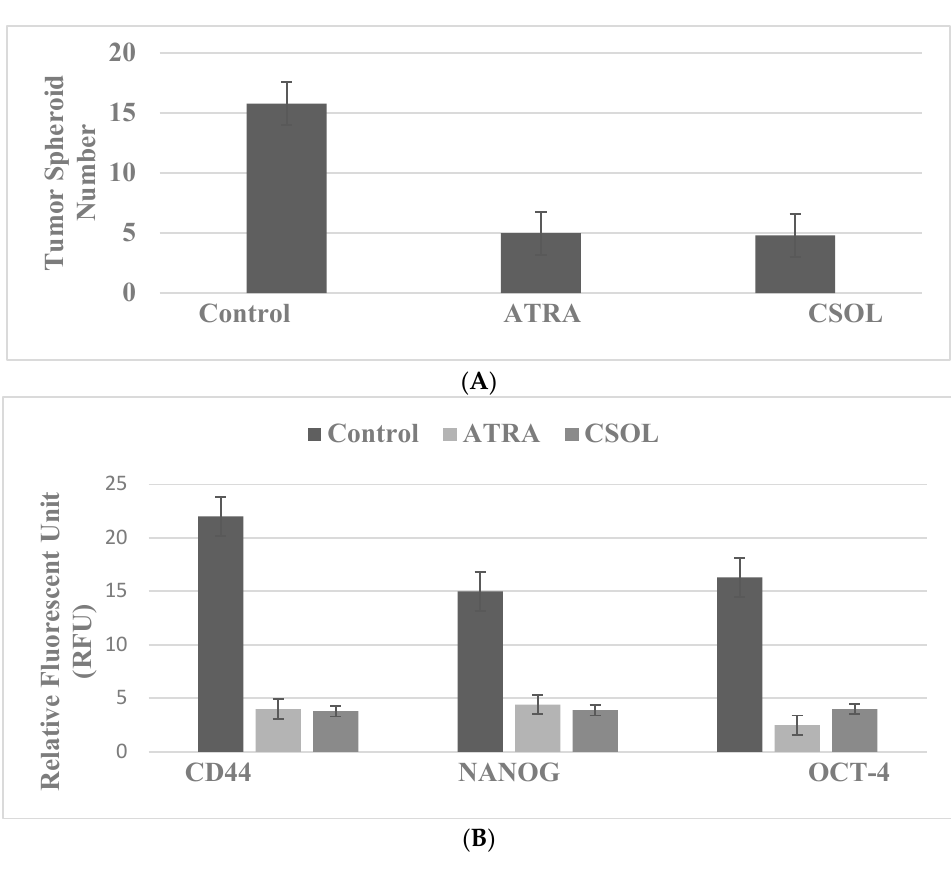
Figure 4. Inhibition of stem cell marker expression in the LAP-R 184-B5/HER model. ( A ) Treatment with ATRA and CSOL decreased tumor spheroid number relative to the solvent control. ( B ) Treatment with ATRA and CSOL decreased the expression of CD44, NANOG and OCT-4 relative to the solvent control. ATRA, all-trans retinoic acid; CSOL, carnosol; CD44, cluster of differentiation 44; NANOG, homeobox transcription factor; OCT-4, octamer-binding transcription factor-4.